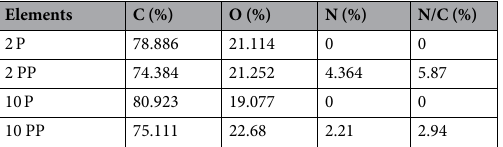
Table 1. Elemental composition of fibrous membrane surfaces.